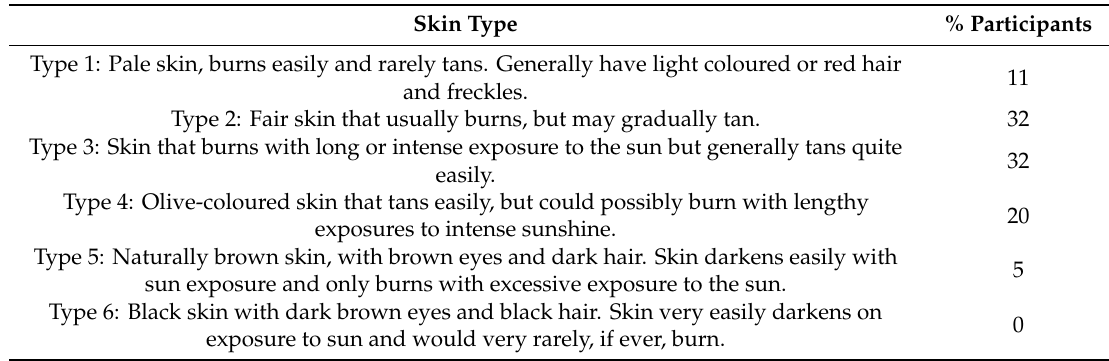
Table 1. Participants’ skin type.